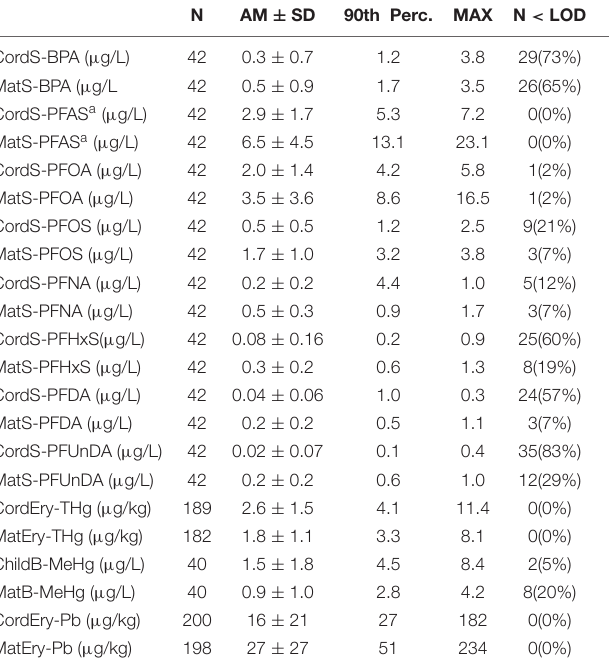
TABLE 3 | Concentrations of Bisphenol A (BPA), Perfluoralkyl substances (PFAS), concentrations for BPA, sumPFAS, PFOA, PFOS, PFNA, PFDA, total mercury (THg), methyl mercury (MeHg), and lead (Pb) in maternal and PFUnDA, PFHxS, THg, MeHg, and Pb ( Figure 3A ). A ratio of 1 newborn blood samples. means equal concentrations in maternal blood and cord N AM ± SD 90th Perc. MAX N < LOD